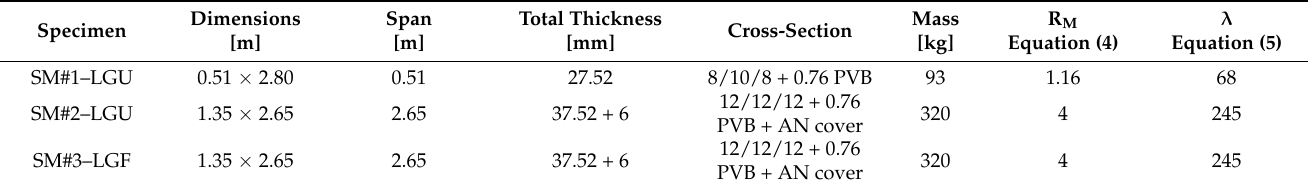
Table 3. Summary of geometrical features for the examined LG pedestrian systems (beam-like simply supported